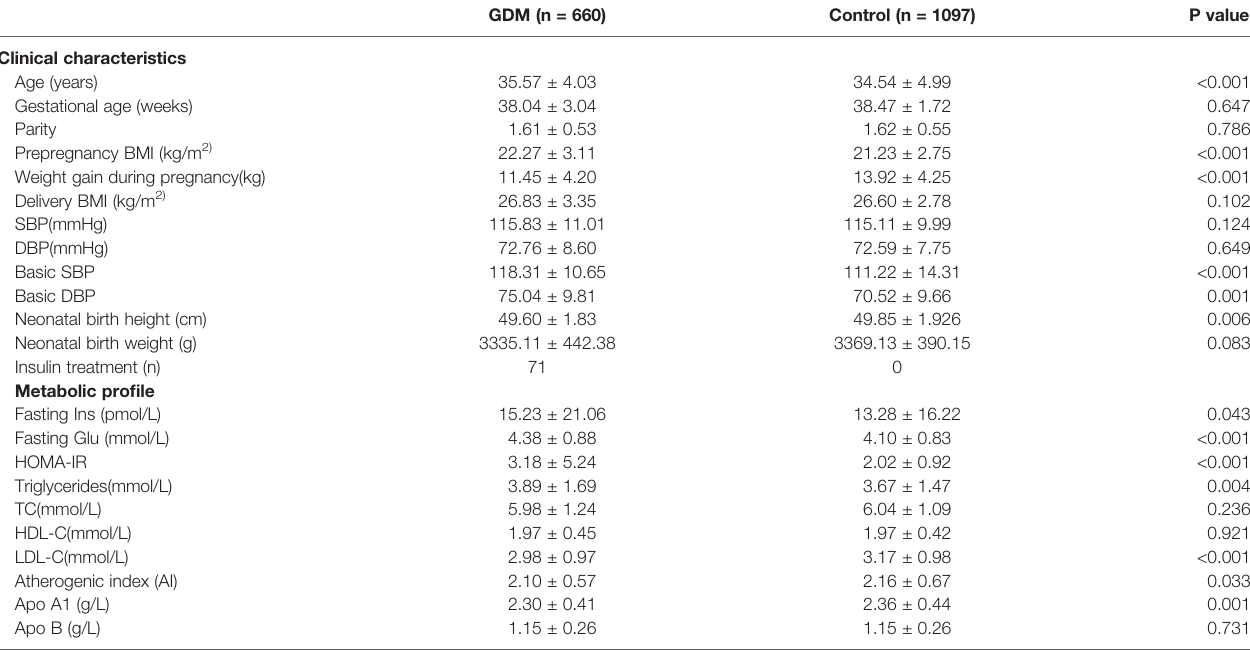
TABLE 1 | Clinical and biochemical characteristics in patients with GDM and control